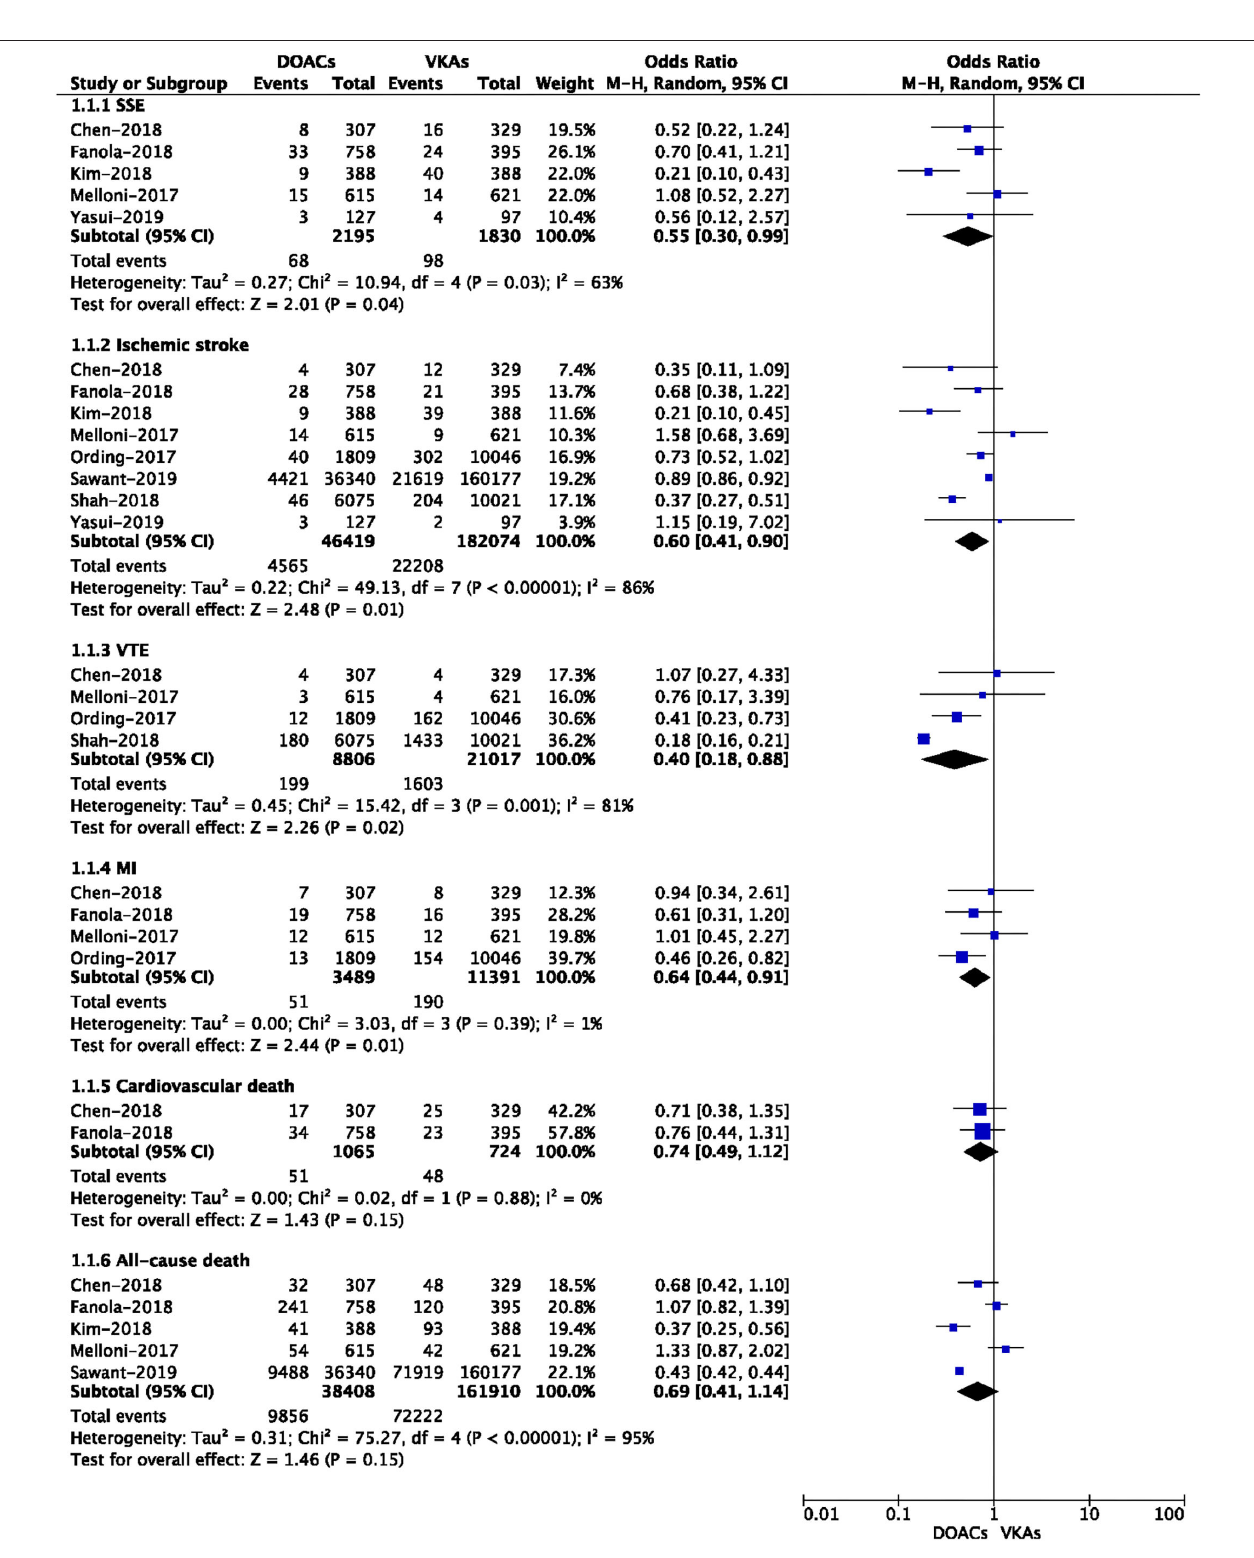
FIGURE 1 | Crude effectiveness event rates of direct oral anticoagulants compared with vitamin K antagonists among atrial fibrillation patients with cancer.